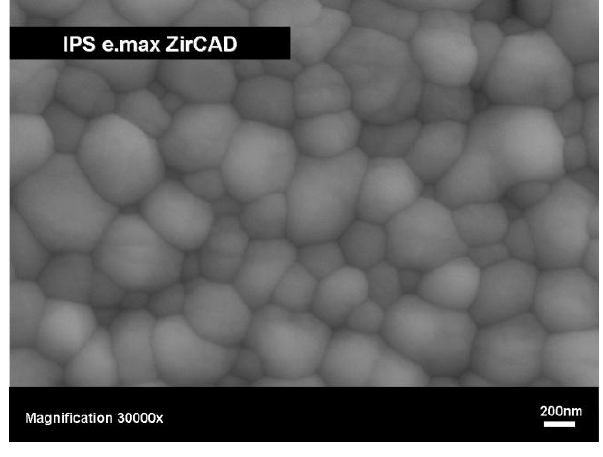
Figure 5. SEM image of the microstructure of IPS e.max  ZirCAD, Ivoclar Vivadent AG, after final densification, polished surface after thermal etched 1420 °C for 15